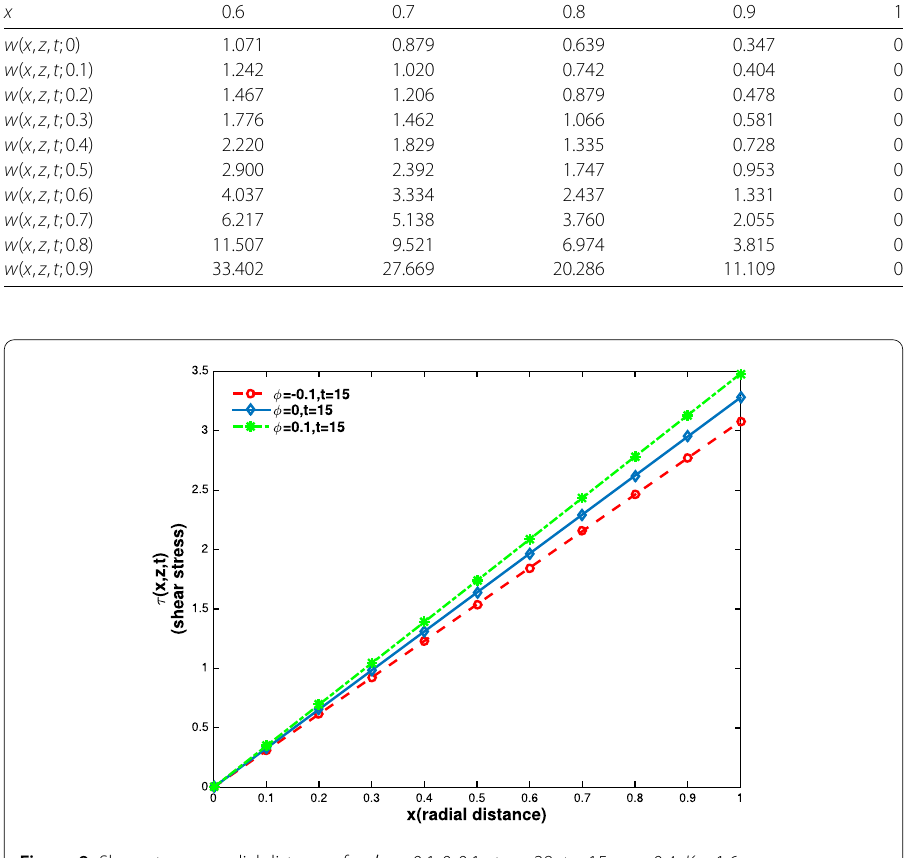
Figure 9 Shear stress vs radial distances for φ = –0.1,0,0.1 at z = 28, t = 15, τ y = 0.4, K =